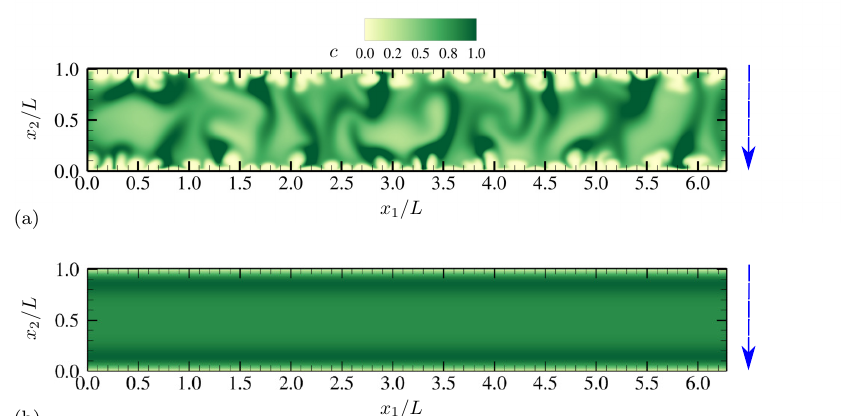
Figure 2. Instantaneous contours of salt concentration c at θ = π for ( a ) ∆ V = 180 and ( b ) ∆ V = 40. ω 0 = 0.063 for both cases. The vertical arrows denote the direction of the The oscillation frequency is applied electric field. The diffusivity ratio is D − / D + = 1. (cid:101)